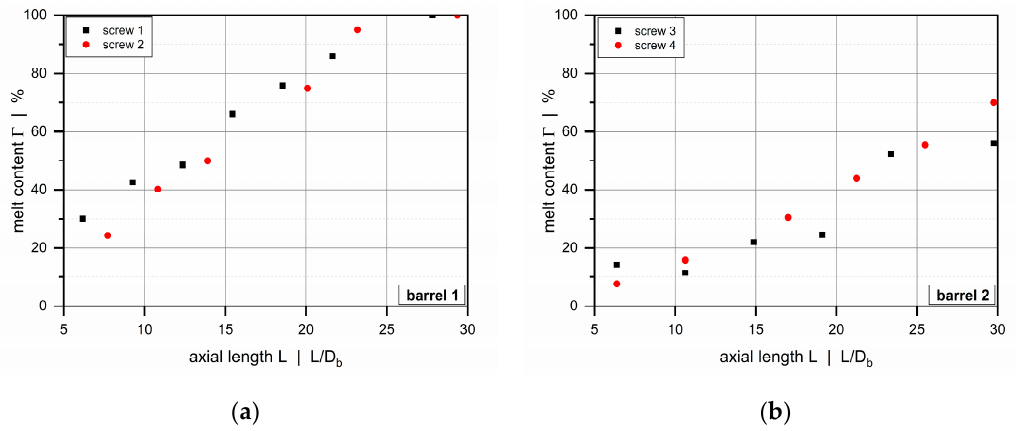
Figure 13. Melting profiles for HDPE for the smooth-bore extruder (barrel 1) ( a ) and the helically grooved-feed extruder (barrel 2) ( b ).